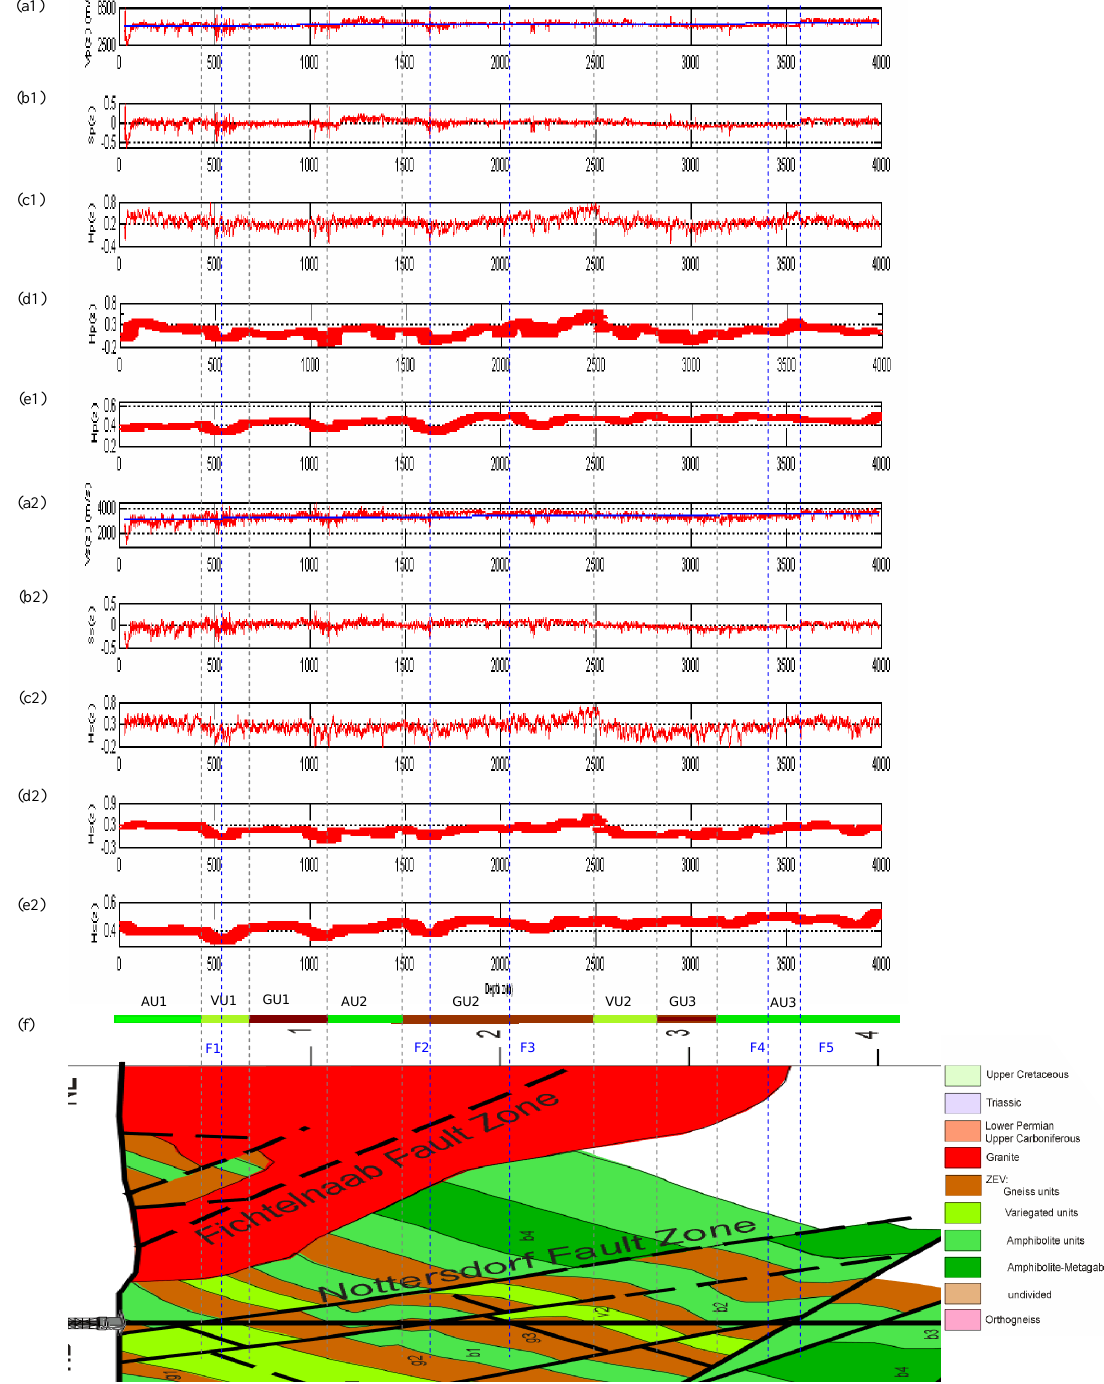
Figure 3. Results obtained from sonic measurements recorded at the pilot borehole (VB). (a1) , (b1) , (c1) , (d1) and (e1) correspond to P-wave velocity log, while (a2) , (b2) , (c2) , (d2) and (e2) are related to S-wave velocity log. Velocity logs (in red) and their respective global linear trends (in blue): (a1)Vp(z) (a2)Vs(z). Fractional fluctuations: (b1)Sp(z) (b2)Ss(z) extracted, respectively, from (a1) and (a2). Local changes of the Hurst parameter H(z) obtained by: LWA: (c1) and (c2); ALWA: (d1) and (d2); and PA: (e1) and (e2); (d1), (d2), (e1) and (e2) are presented with statistical error bars. (f) A lithologic sketch modified from http://icdp.gfz-potsdam.de/html/ktb. Blue line: faults contacts; gray line: lithological